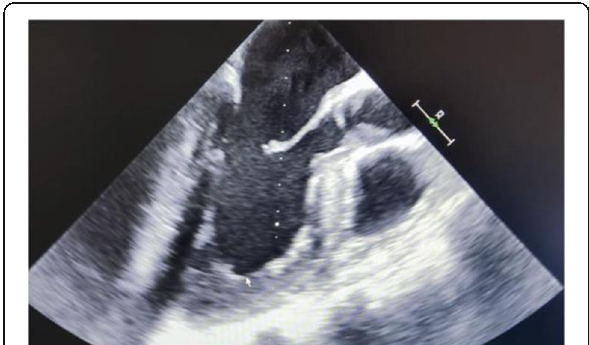
Fig. 1 (abstract A164). Subaortic Stenosis